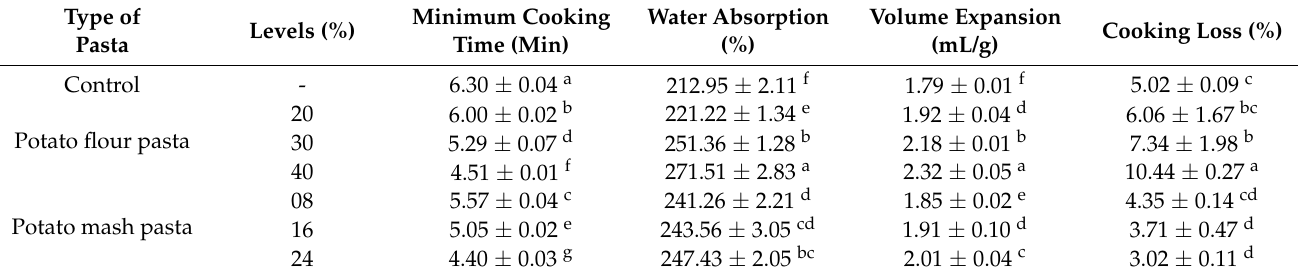
Table 3. Effect of replacing potato powder and mash with semolina on the cooking quality of the